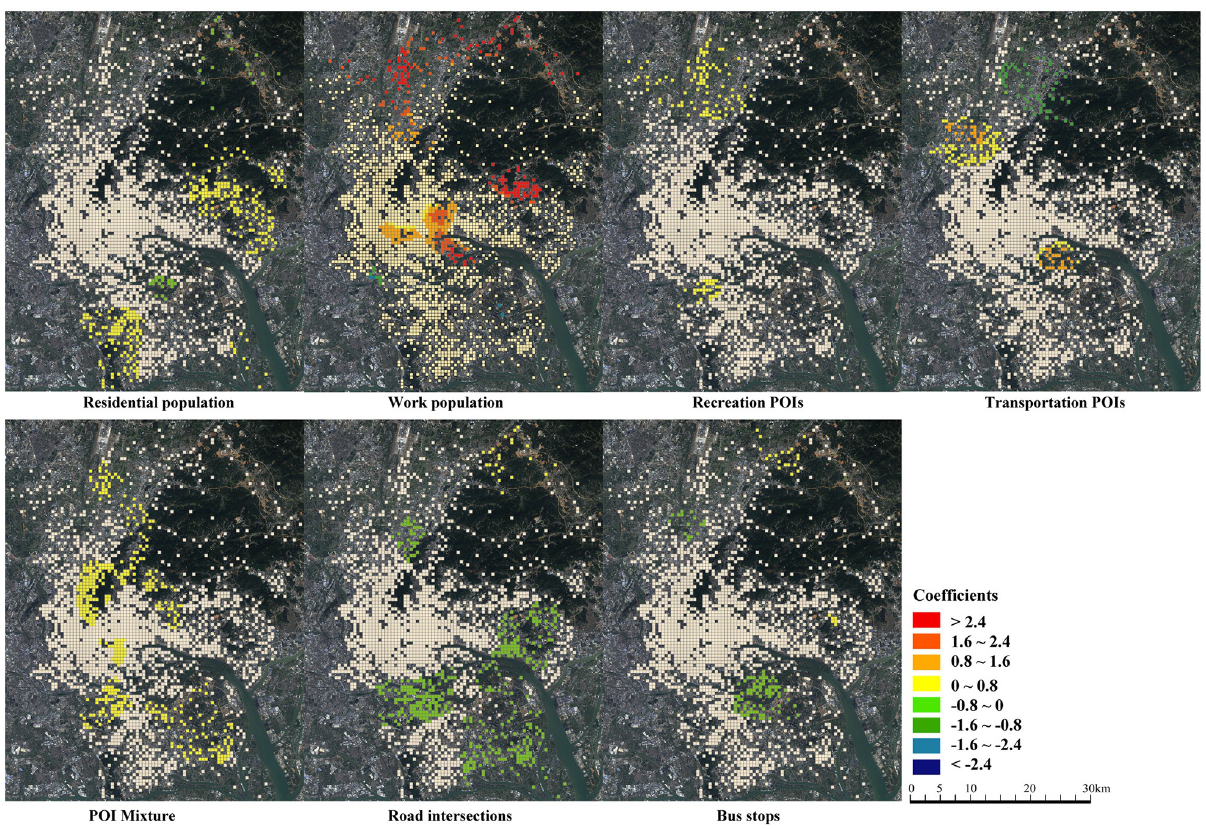
Fig 4. Distributions of coefficients in the home-based